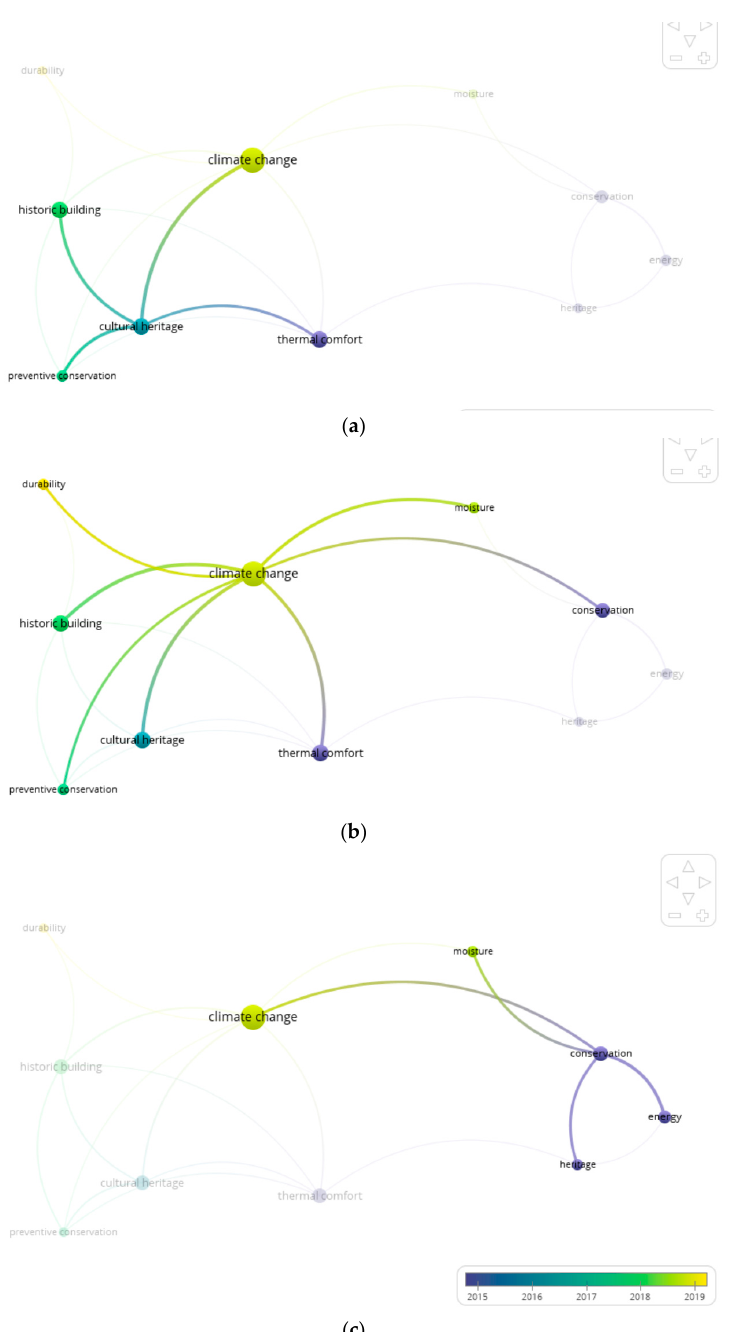
Figure 9. Network visualization of author keywords co-occurrence and links of the “leading” key- words ( a ) “Cultural heritage”; ( b ) “Climate change”; ( c ) “Conservation”.